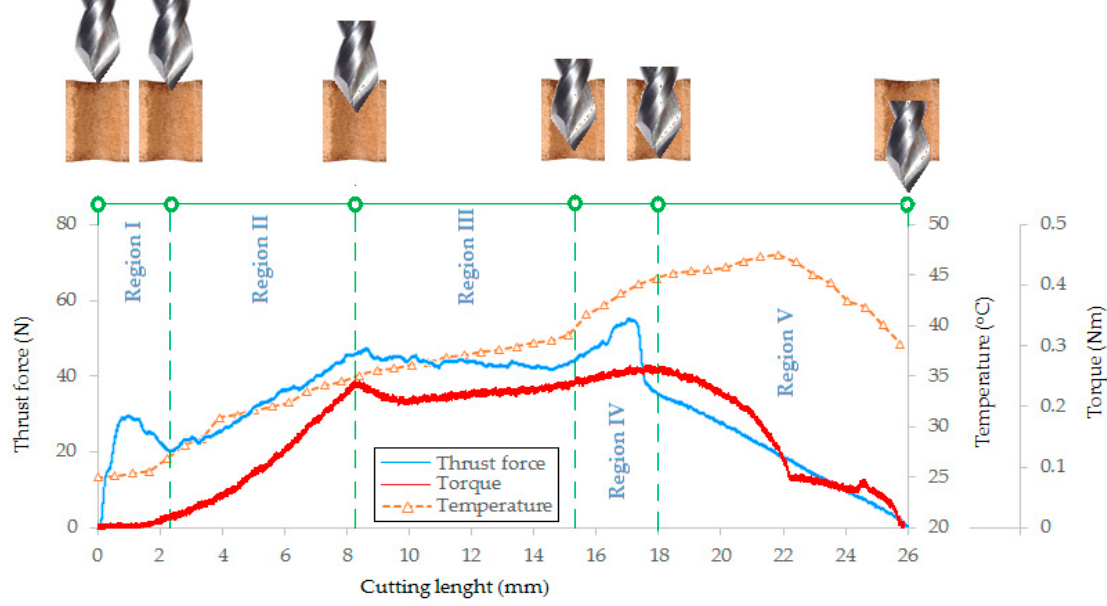
Figure 12. Variation of thrust force, cutting torque and temperature in the drilling process.